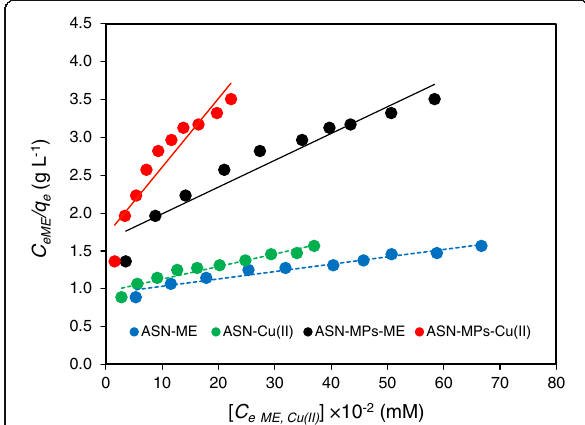
Fig. 11 The Multiple linear regression of ME and Cu(II) cations on ASN and ASN-MPs by the binary Langmuir isotherm adsorption